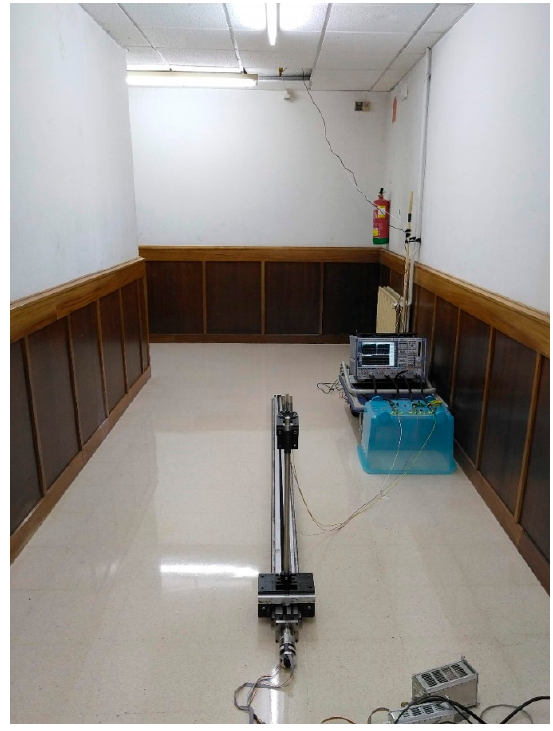
Figure 5. Picture of the corridor during the measurement campaign.